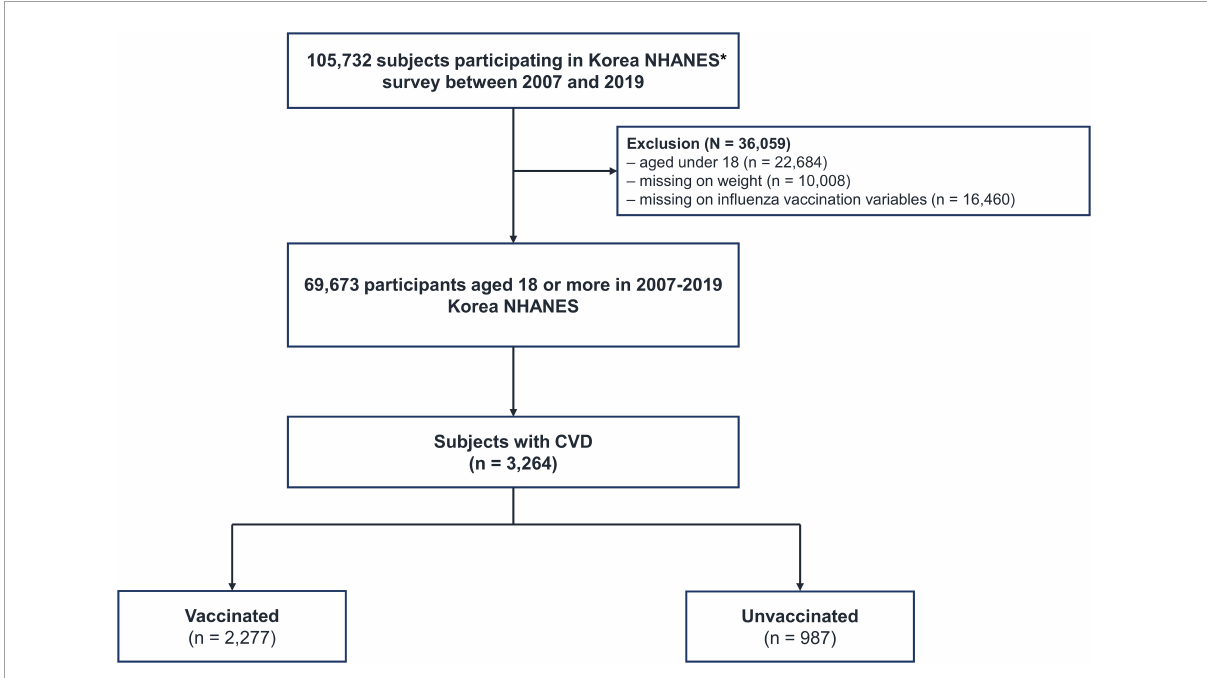
FIGURE1 Flow chart of the study population. CVD, cardiovascular disease; NHANES, National Health and Nutrition Examination Survey. *Data from NHANES V (2013) were excluded because vaccination data were not